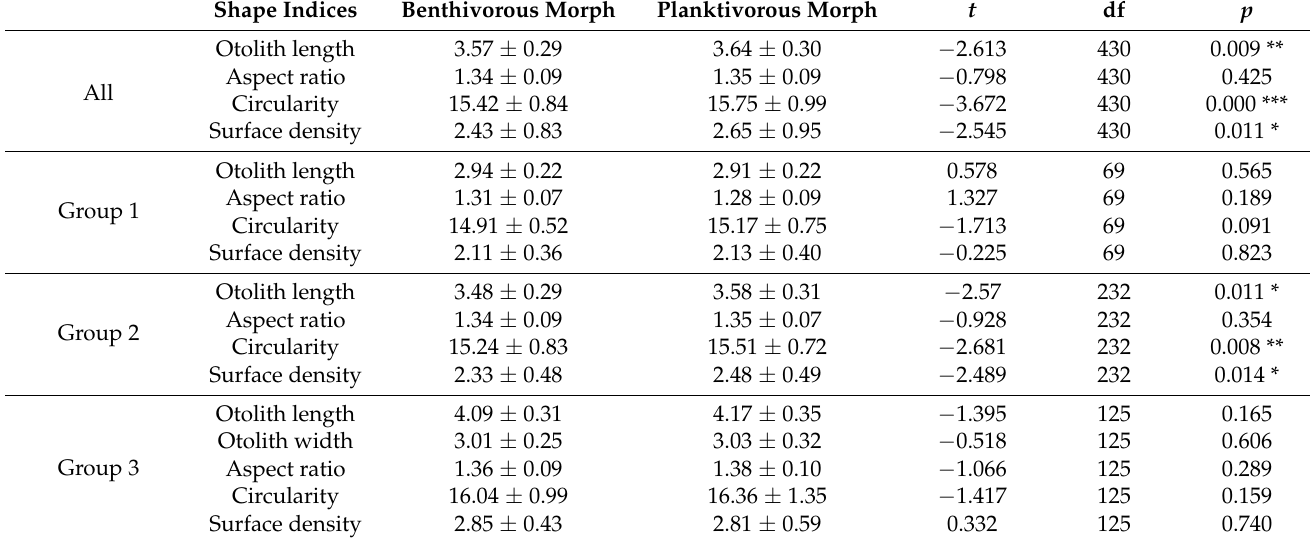
Table 4. Results of Student’s t -test of two morphs of Schizopygopsis thermalis based on otolith shape indices which contained the combination of all TL groups, first TL group, second TL group, and